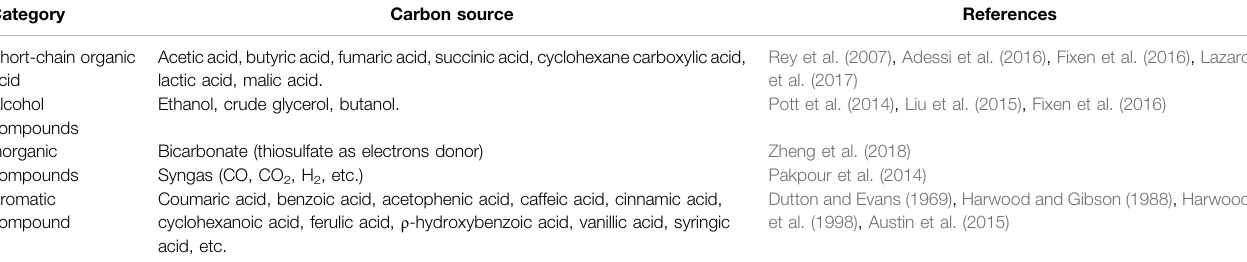
TABLE 1 | Carbon sources utilized by R. palustris